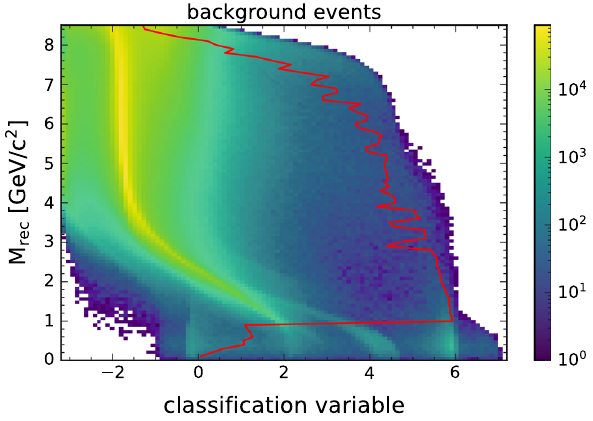
Fig. 7 The output distribution of all background events after the BCE pretraining, overlaid with the optimal decision threshold for each signal signal hypothesis